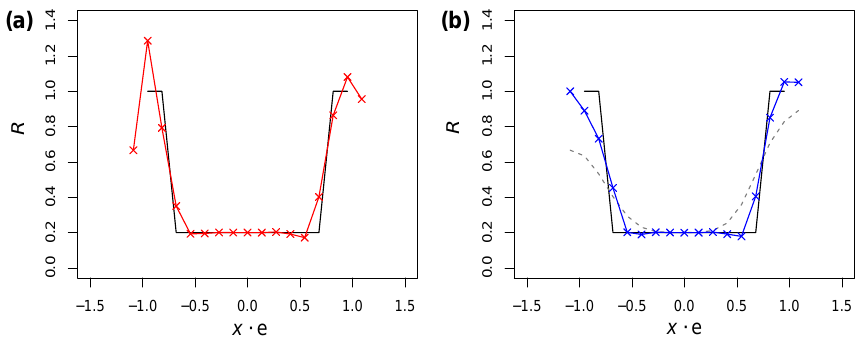
Fig. A1. Results from the one-dimensional advection test after Sch¨ar and Smolarkiewicz (1996). The isotope ratio R at time t = 1 is plotted against the stretched spatial dimension. Solid black lines indicate the analytical solution. The red line in (a) shows the numerical result for both isotopes being transported independently of each other using the original Bott scheme. In (b) , the blue line shows the isotope ratio obtained with the modified advection with fourth order accuracy, the gray dashed line indicates the result obtained with zeroth order accuracy. See text for